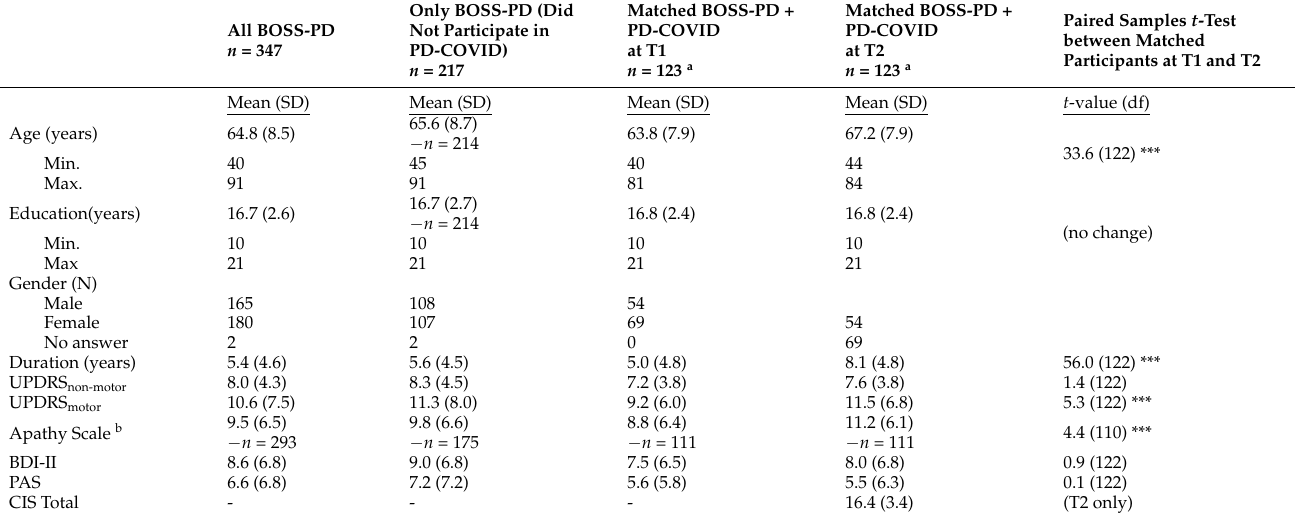
Table 2. Demographic and Clinical Characteristics and Performance on Measures for Participants in BOSS-PD and PD-COVID, and Comparison between Matched BOSS-PD + PD-COVID Participants